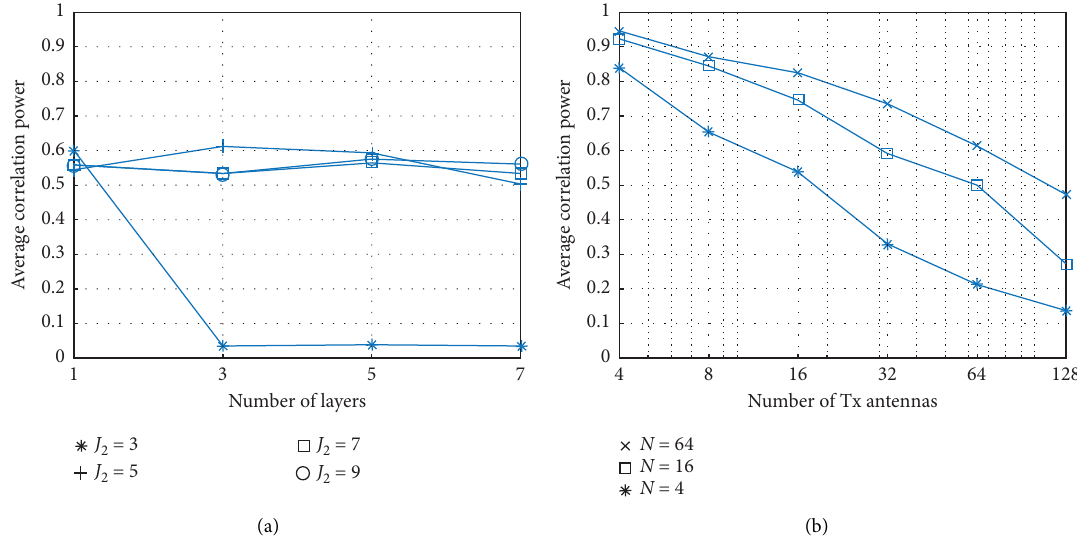
Figure 6: Average correlation power performance of the proposed DNN structure using (a) diferent numbers of layers and nodes and (b) diferent sizes of the codebook and transmit antenna